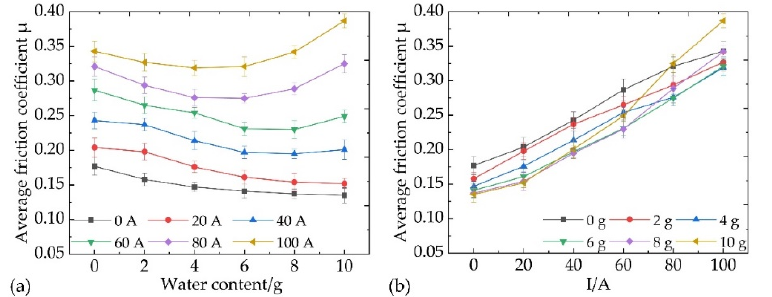
Figure 2. Effect of water content on the AFC of C-Cu contacts: ( a ) under different currents; ( b ) under water content.